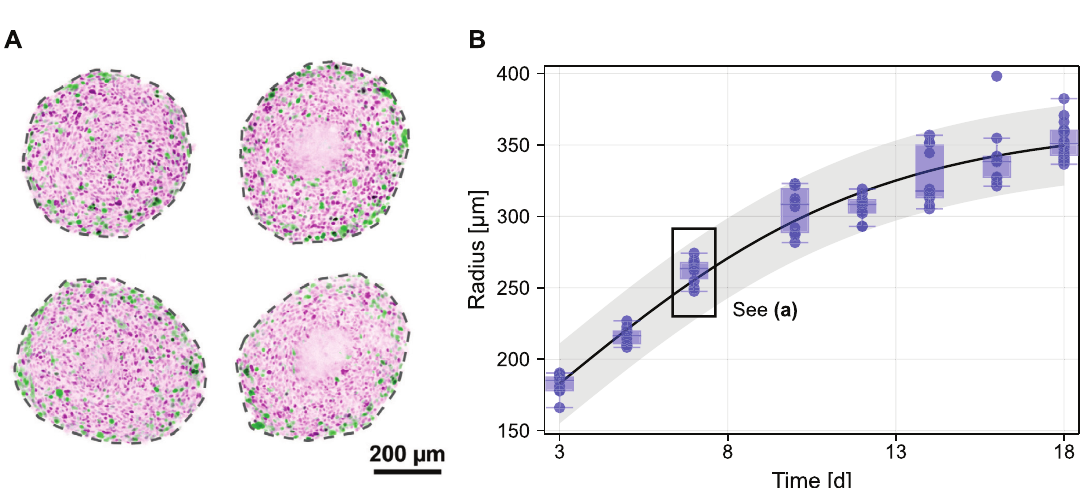
Fig 1. Heterogeneity in experimental measurements of spheroid growth. (A) Microscopy images of tumour spheroids grown from melanoma cell line WM983b from which a subset of measurements in (B) were taken. Spheroids were grown from 5000 cells, harvested, fixed, and imaged after nine days. Cells are transduced with fluorescent cell cycle indicators: colouring indicates cells in gap 1 (purple) and cells in gap 2 (green). In all but one spheroid, a lack of definition in the spheroid centre indicates the presence of a necrotic core. (B) Images are summarised by the radius of a circle with equivalent cross-sectional area as microscopy images. Shown are experimental measurements (blue discs and box plots) and a calibrated logistic model with prediction interval based on additive normal noise. Data from